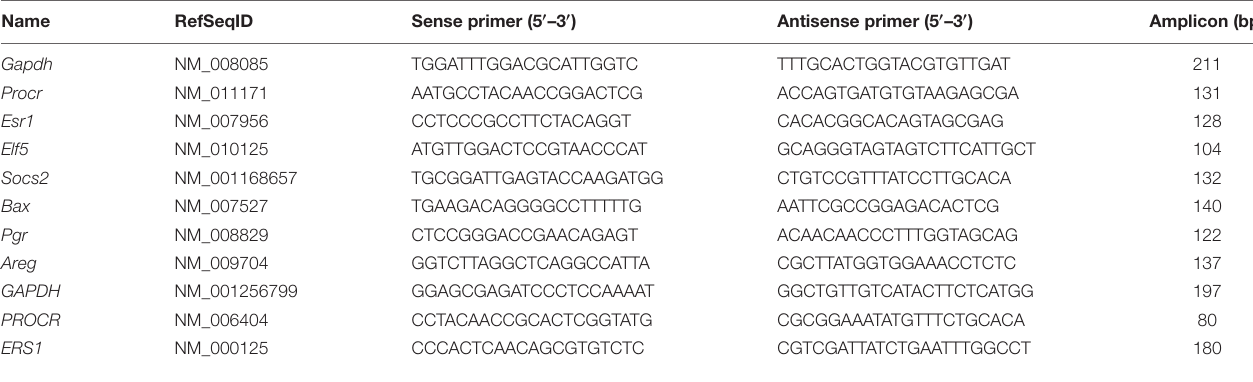
TABLE 1 | Primers designed for real-time